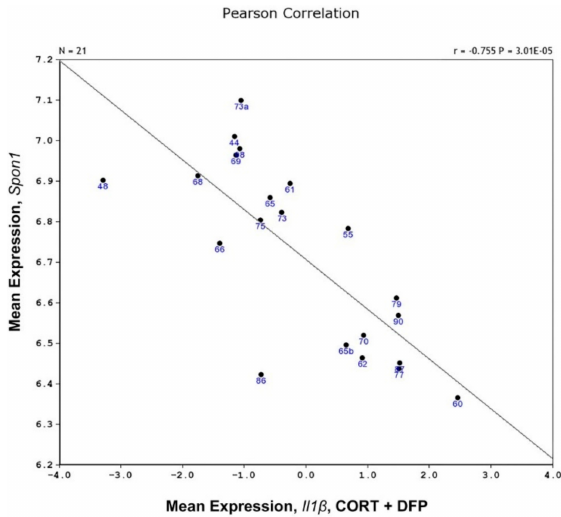
Figure 9. Scatter diagram of the association between the expression of Spon1 and the eigenvariable relative to Il1b expression in mice treated with corticosterone and